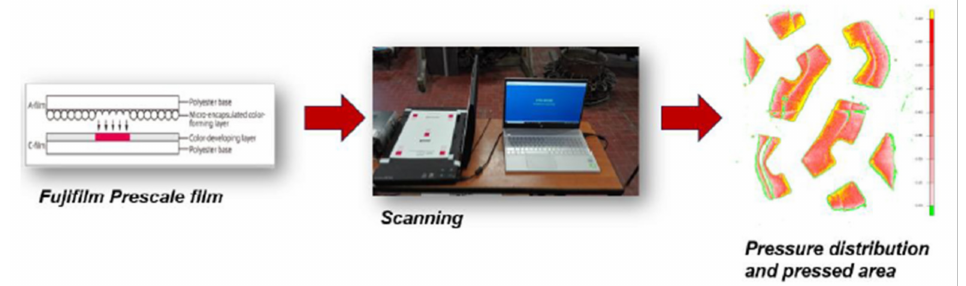
Figure 3. Contact patch acquisition